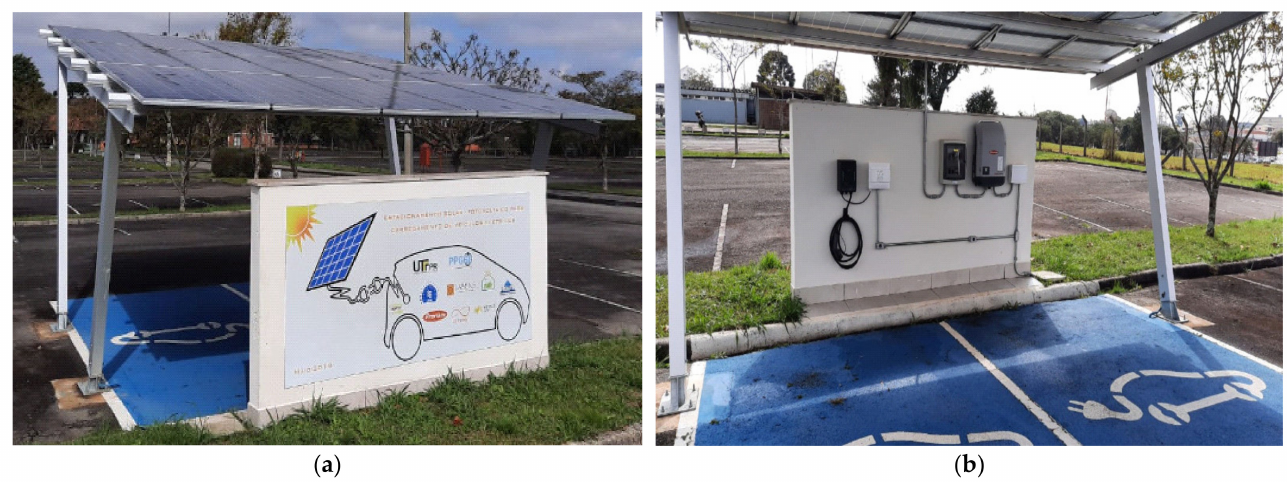
Figure 3. Current carport installations: ( a ) External; ( b ) Internal.